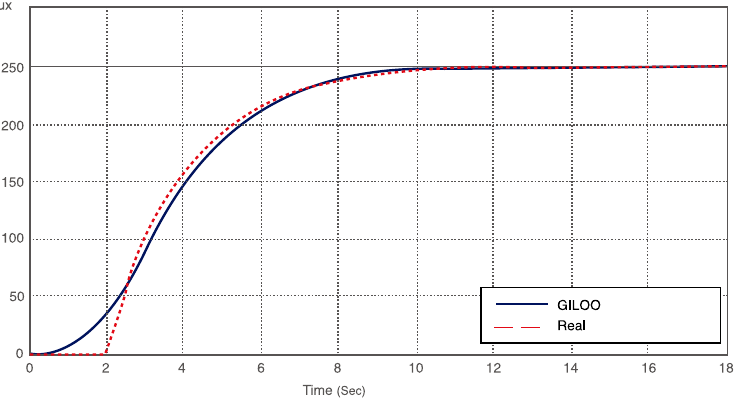
Figure 13. Lux level of a real experiment (dotted) and for the GILOO experiment